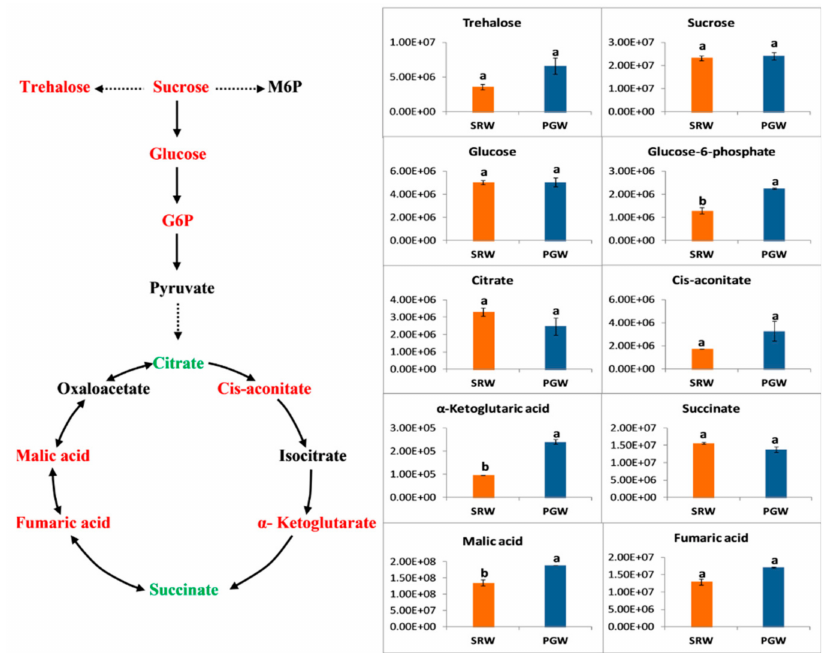
Figure 2. Y -axis shows changes in relative contents of metabolites associated with carbon metabolism between mature fruit of pumpkin-grafted watermelon (PGW) and self-rooted watermelon (SRW). Red or green color shows the higher content of metabolites in PGW or SRW, respectively. Vertical bars represent standard error among three independent replicates. Values are the mean ± SE of three replicates. Different lowercase letters indicate significant differences at p < 0.05. M6P, maltose-6- phosphate; G6P,